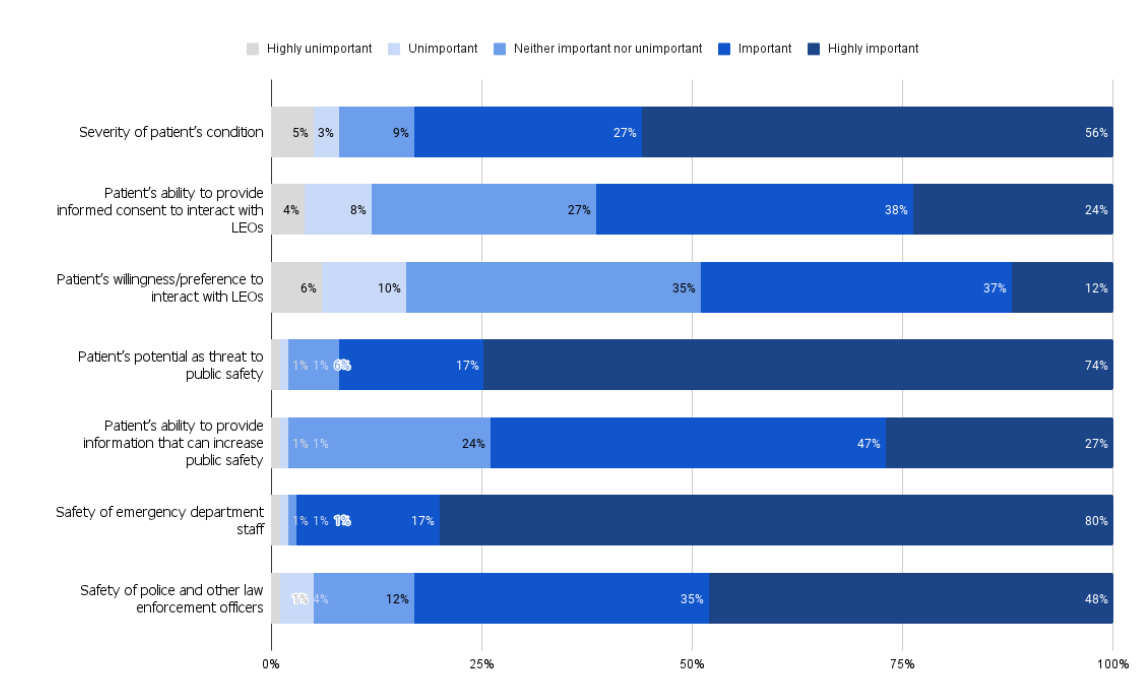
Figure 3. Factors influencing the emergency physician’s decision to allow law enforcement access to emergency department patients. LEO, law enforcement